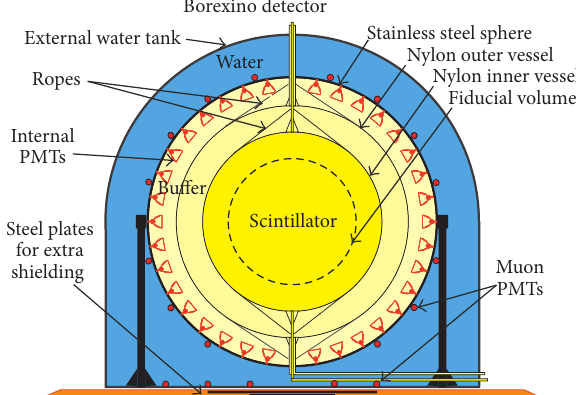
Figure 2: Sketch of the Borexino experiment, highlighting its major components arranged according to a graded shielding